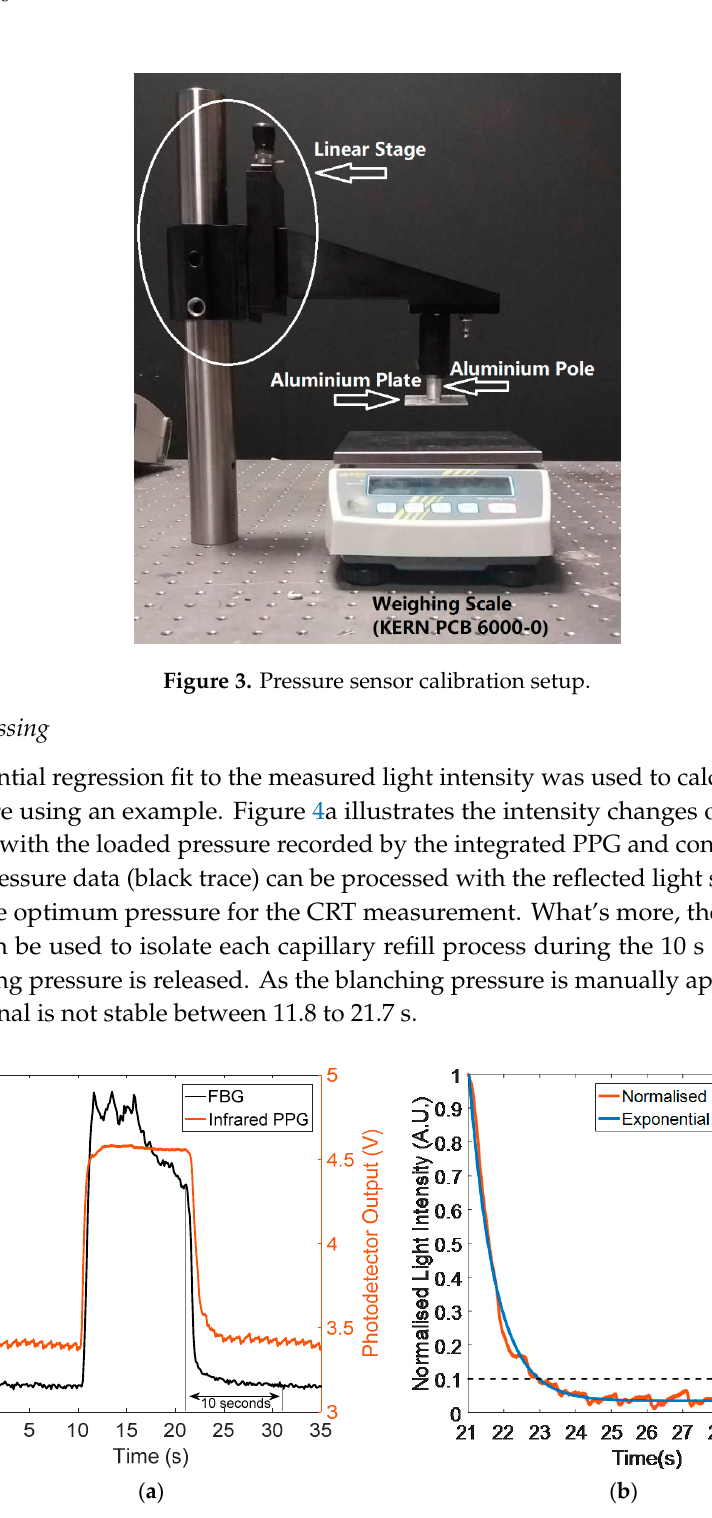
Figure 4. ( a ) Intensity changes (red curve) with loaded pressure (black curve). From 0 to 10 s, there is